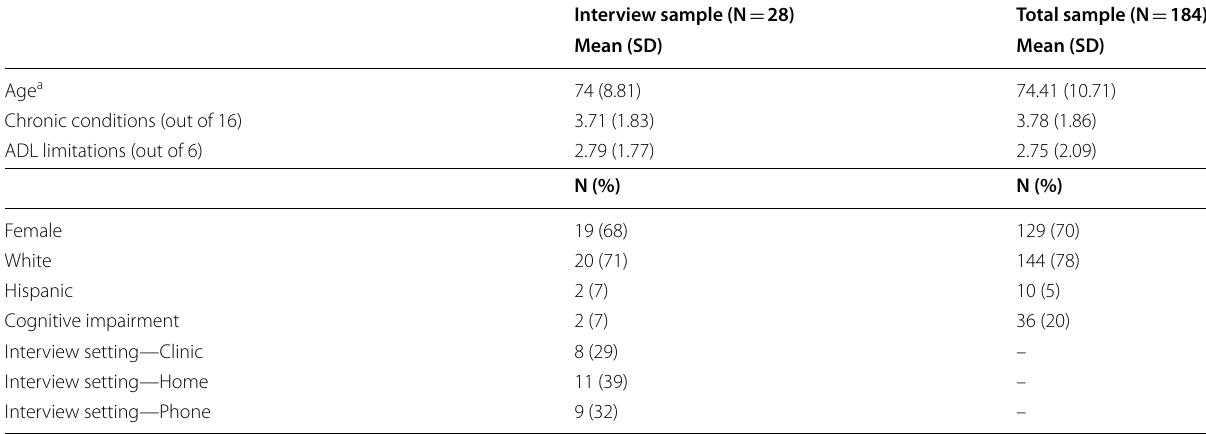
Table 2 Comparison of patients interviewed to total